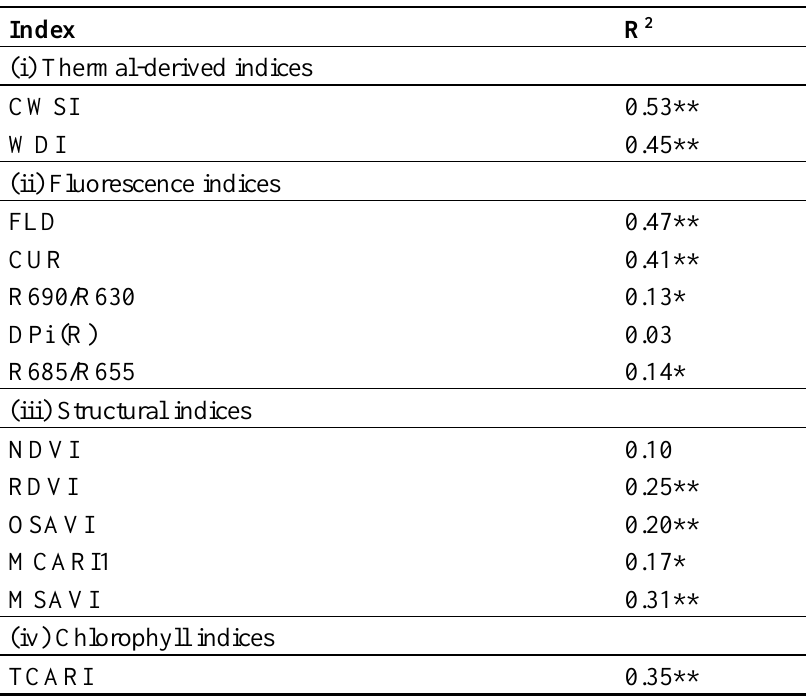
Figure 8. Relationship between yield (kg·ha −1 ) and: CWSI ( a ), fluorescence (FLD) ( b ), PRI ( c ) and NDVI ( d ) for durum (solid symbols) and bread wheat (open symbols). Each point represents the average of the three replicates of each variety. Table 2. Coefficient of correlation (R 2 ) and level of significance of the thermal- and hyperspectral-derived indices related with